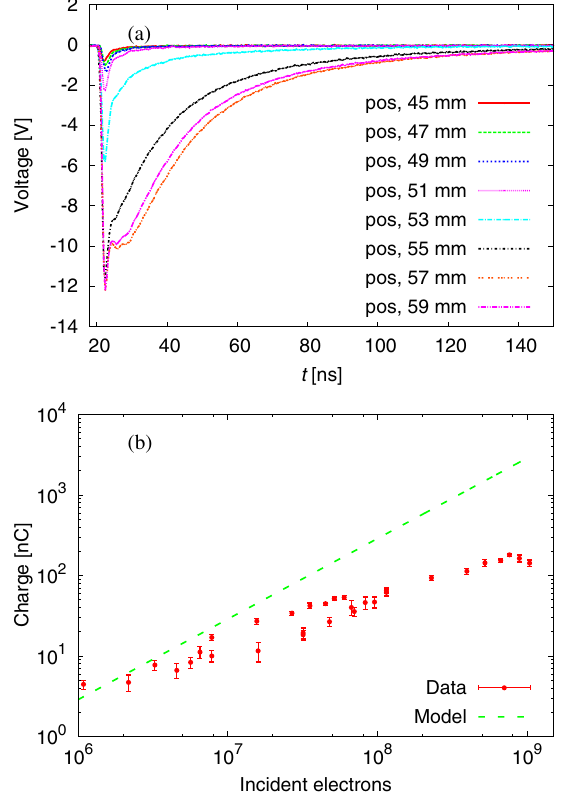
FIG. 7. Typical waveforms measured with the DS within the core region where beam center at around 57 mm (a) and charge signal as a function of the quantity of collected electrons